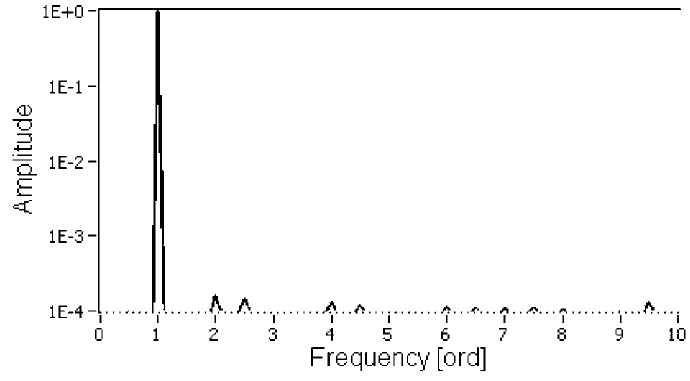
Fig. 17. Order spectrum using multiple pulses per revolution.